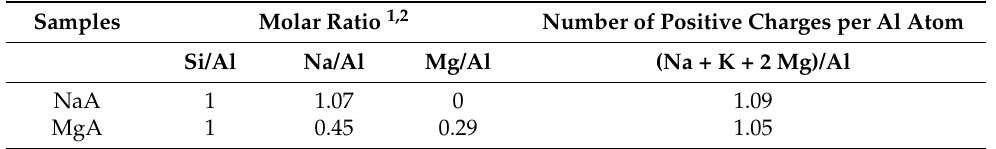
Table 1. Chemical composition of LTA-type zeolite and its associated magnesium form determined by XRF (Si/Al, Na/Al, Mg/Al, and K/Al Molar ratio). Samples Molar Ratio 1,2 Number of Positive Charges per Al Atom Si/Al Na/Al Mg/Al (Na + K + 2 Mg)/Al NaA 1 1.07 0 1.09 MgA